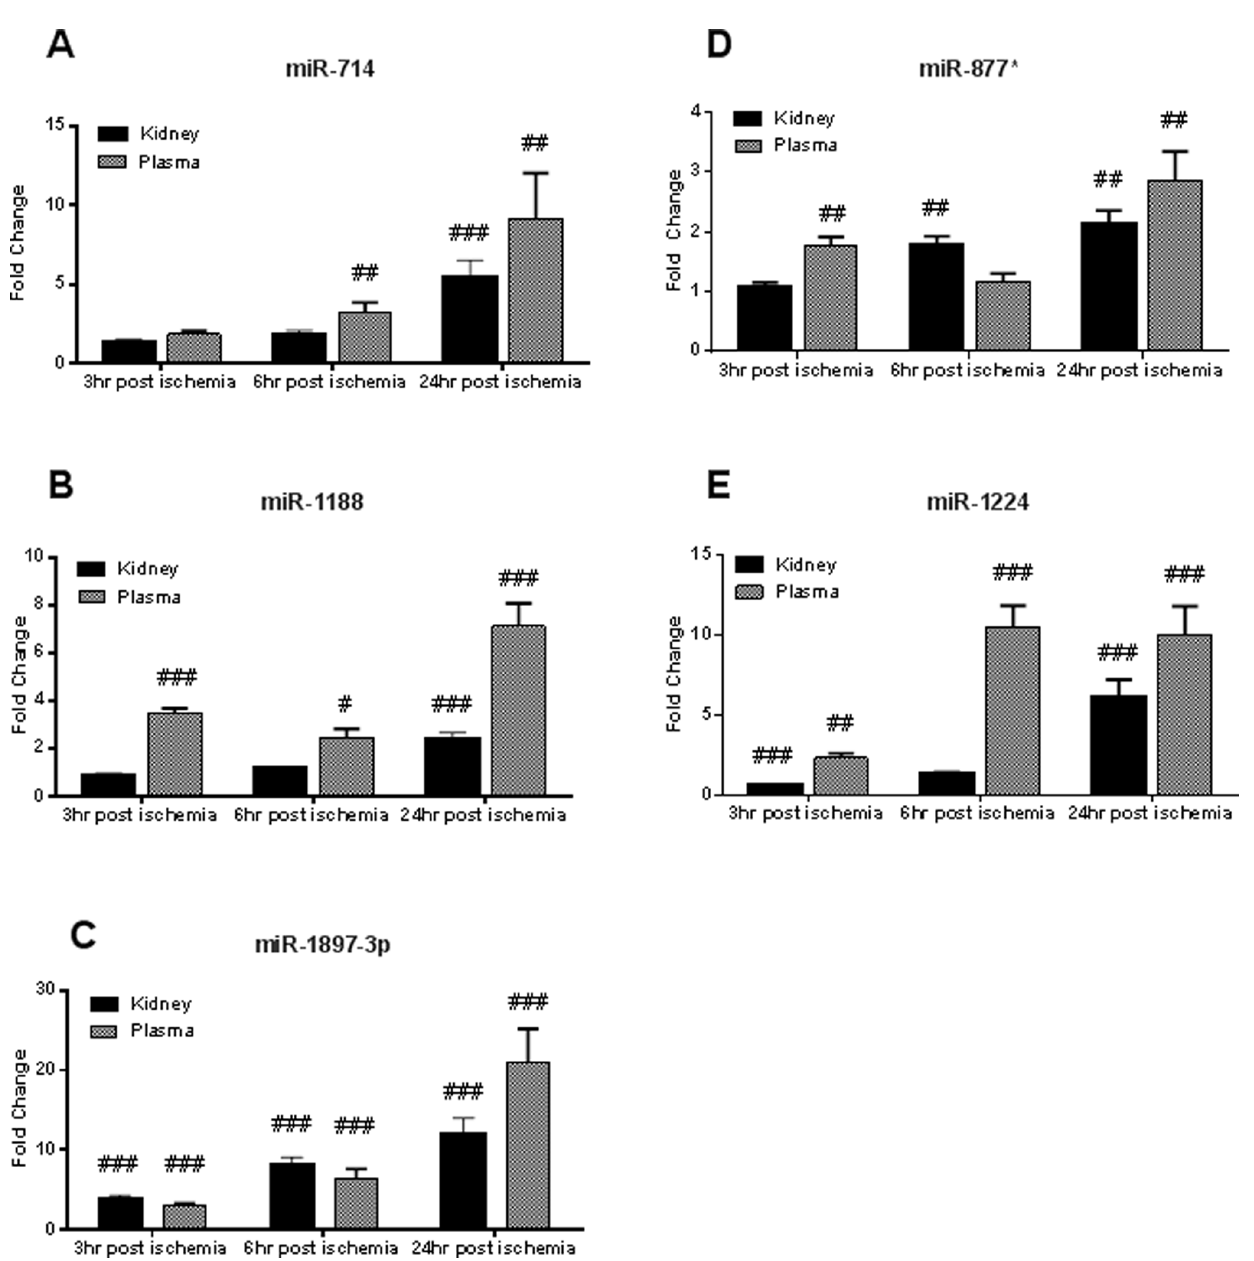
Figure 5. MicroRNA expression confirmation by real-time PCR in the samples from individual animals. Eleven microRNA species were selected on the basis of concordant and discordant changes in the kidney and plasma as detected in the pooled samples. The changes in five microRNAs were confirmed in the samples from individual animals. Bars on graphs represent fold changes from the time-matched sham-operated animals. MicroRNA expression levels form the sham-operated animals (not shown on graphs) are set to 1. Panel A shows miR-714 changes in kidney and plasma. Panel B shows miR-1188. Panel C shows miR-1897-3p. Panel D shows miR-877*. Panel E shows miR-1224. Two sample t tests were performed on sham and ischemic groups at each timepoint, then p values were adjusted with Bonferroni correction. # =p , 0.05; ## =p , 0.01; ### =p , 0.001. studies are needed to identify specific cell type producing them. Nevertheless, given that among multiple microRNAs modulated by ischemia-reperfusion in the kidneys and plasma, only few species were changed in a coordinated manner, it is tempting to